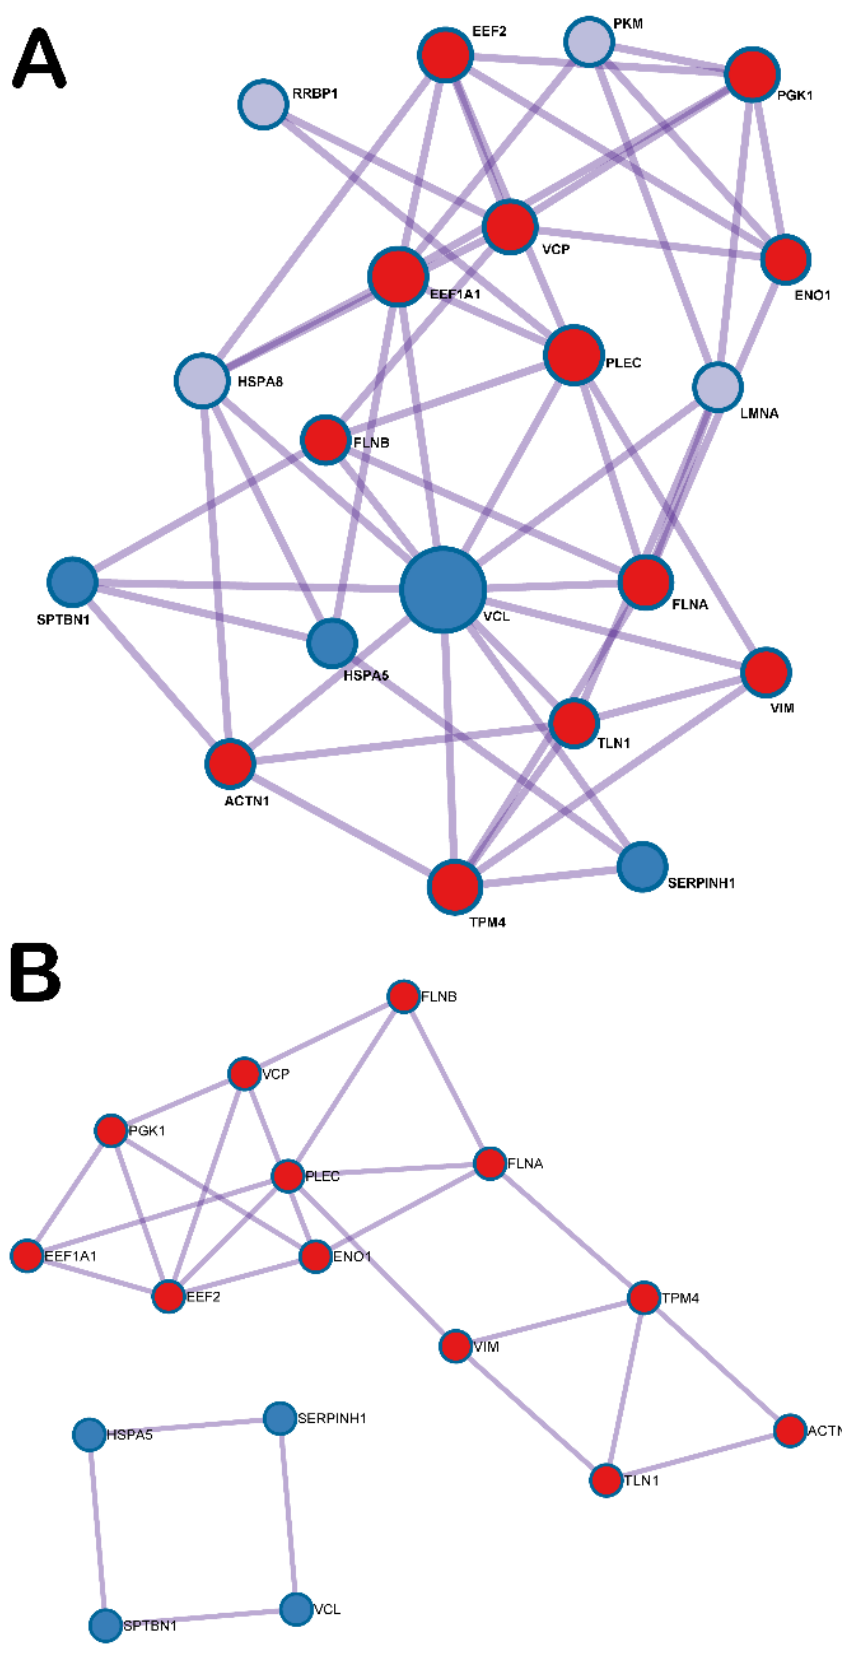
Figure 5. ( A ) Protein-protein interaction network and MCODE components identified from the abundant exosomal protein lists; ( B ) The functional network of the protein-protein interaction